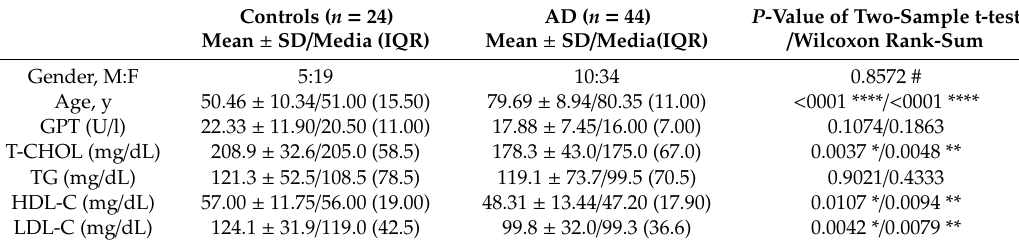
Table 1. Biochemical profiles of the healthy controls and patients with Alzheimer’s